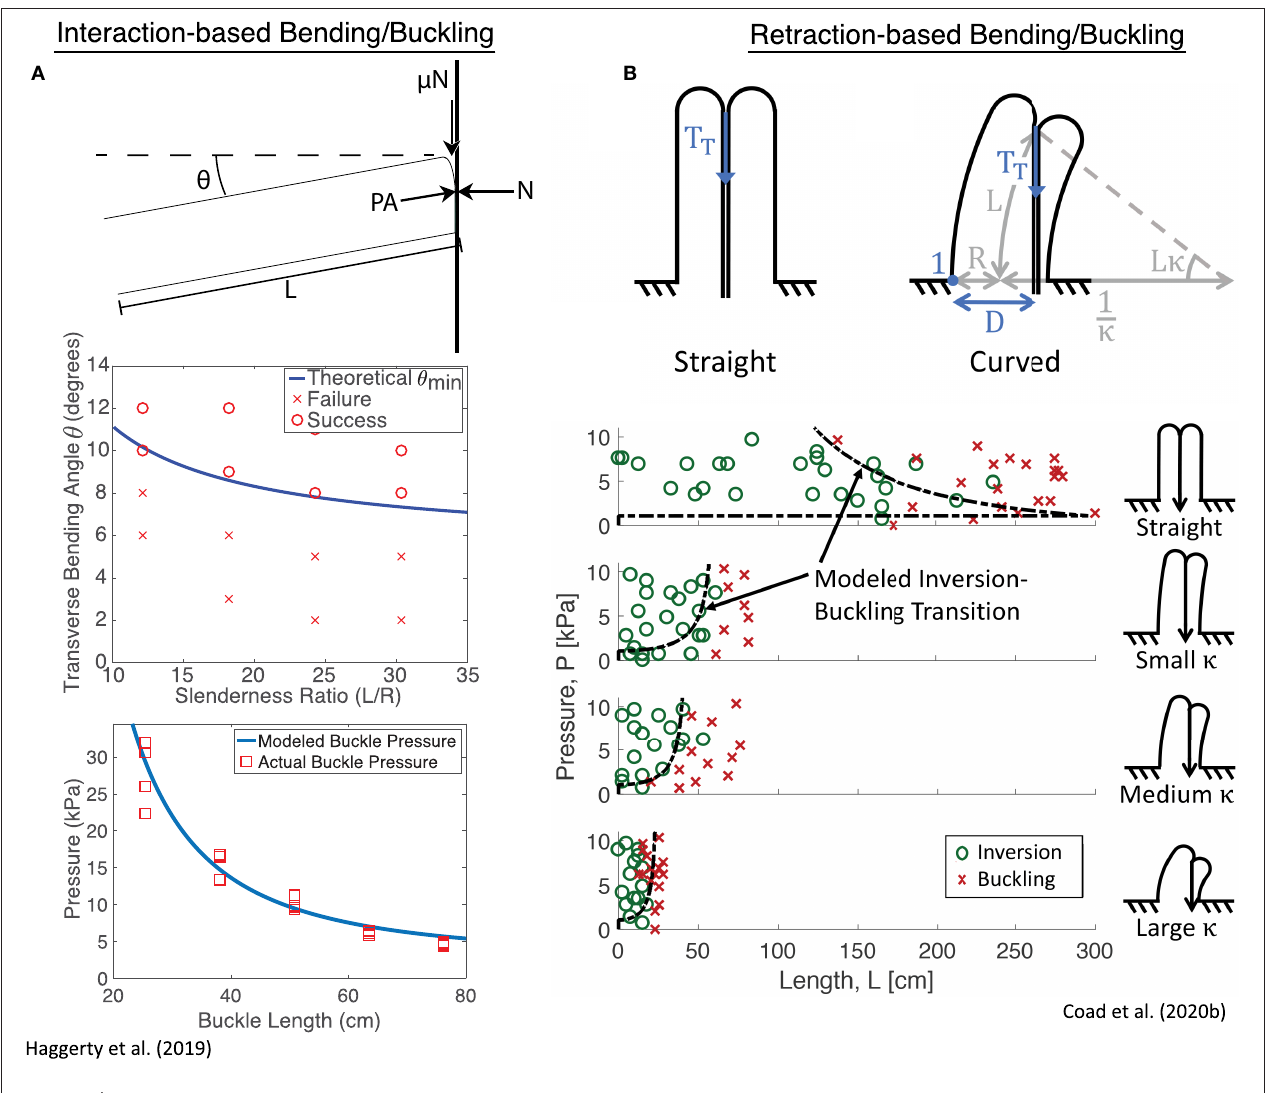
FIGURE 7 | Quasi-static modeling of everting vine robot bending and buckling during growth into obstacles, as well as retraction. (A) Modeling of bending and buckling based on environment interaction allows prediction of the pressure required to passively deform through an environment during growth. (B) Modeling of bending and buckling based on retraction forces allows prediction of when the robot will invert successfully. Modified from Haggerty et al. (2019) © IEEE 2019 and Coad et al. (2020b) © IEEE